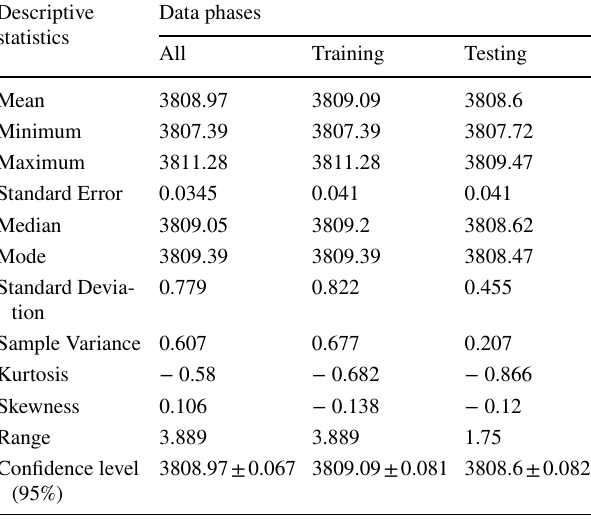
Table 1 Descriptive statistics of the data used in the present study Descriptive